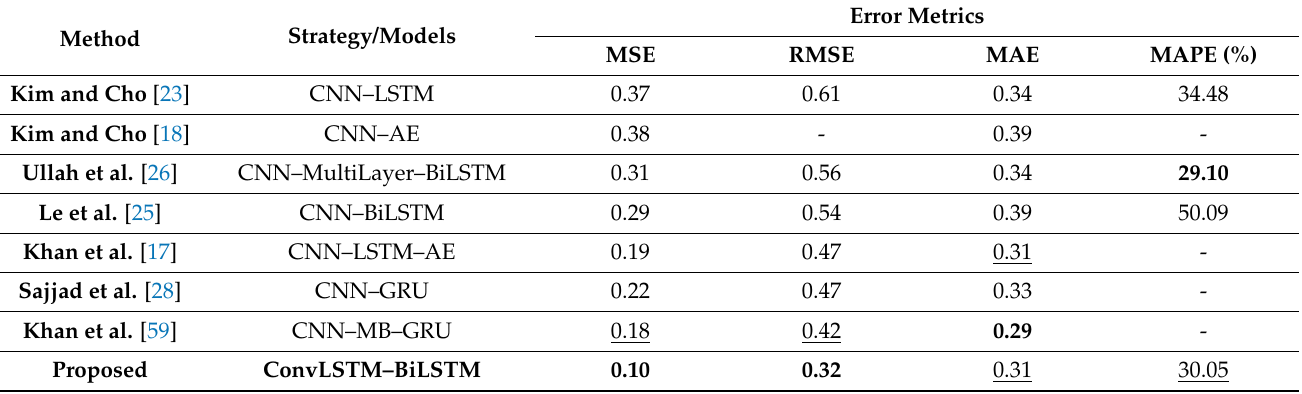
Table 9. Comparative analysis of the proposed model with state-of-the-art models based on hourly data resolution of Household